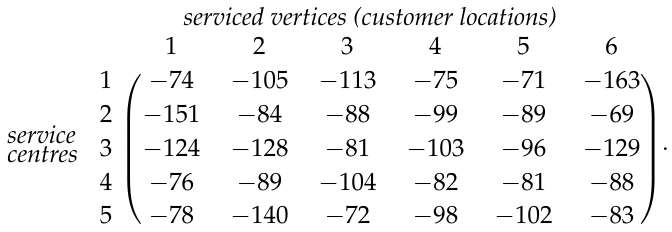
Table 4. Reference Signal Received Power Categories for Sub-6 GHz 5G service mode [76,77]. RSRP [dBm] Signal Strength Description 80 Excellent Strong signal with maximum data speeds ≥− 80 to 90 Good Strong signal with good data speeds − − 90 to 100 Fair to poor Reliable data speeds may be attained, but marginal data with − − drop-outs is possible. When this value gets close to performance will drop drastically 100 No signal ≤−